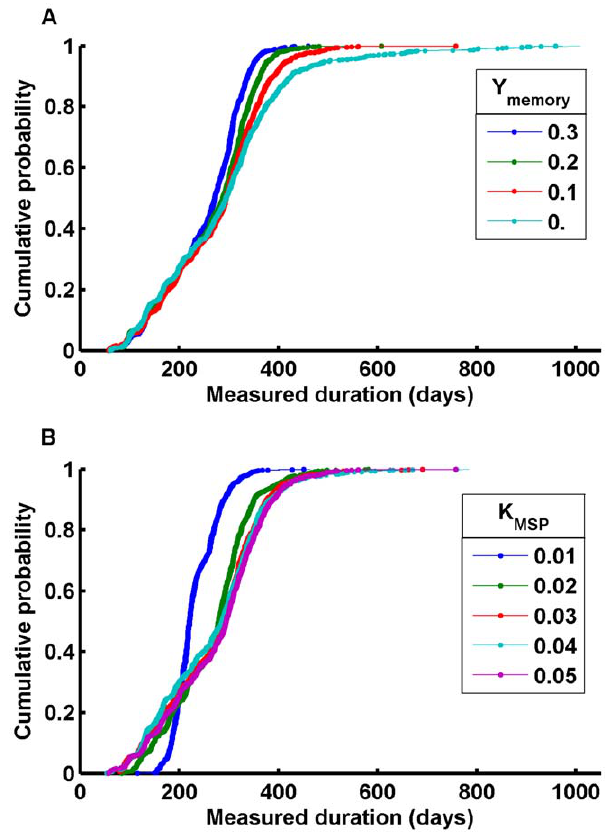
Figure 4. Effects of immunological memory and merozoite invasion-blocking immunity. A) Effect of memory level Y memory on duration distribution; B) Effect of merozoite-specific antibody capacity growth rate K MSP on duration distribution. Infection parameters are the same as they are in Figure 3, but K MSP is fixed at 0.05 in a), and Y memory is fixed at 0.1 in